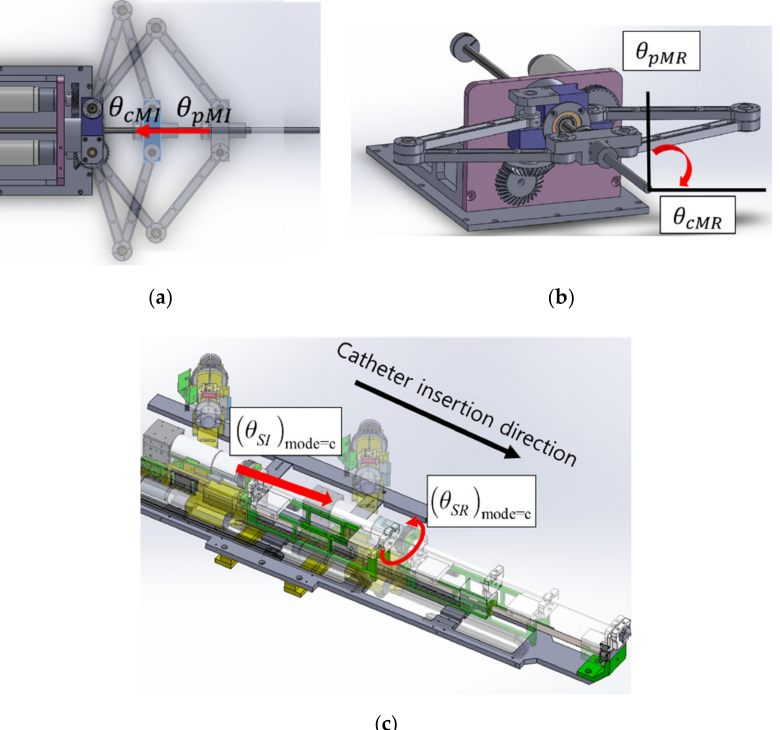
Figure 6. Motions of the ergonomically designed 2 DOFs master device and catheter module of the 7 DOFs VI slave robot: ( a ) insertion motion; ( b ) rotation motion; and ( c ) movement of the catheter module of the slave robot according to the motion of the ergonomically designed 2 DOFs master device. Appl. Sci. 2021 , 11 , 5453